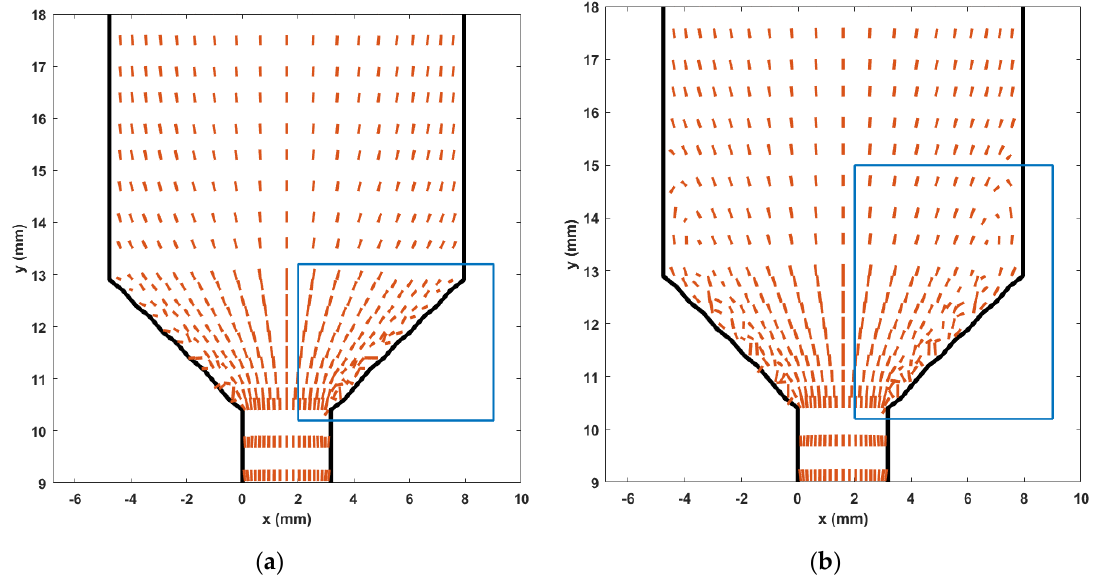
Figure 18. Fiber orientation tensor vector field: ( a ) uncoupled solution; ( b ) fully coupled solution.